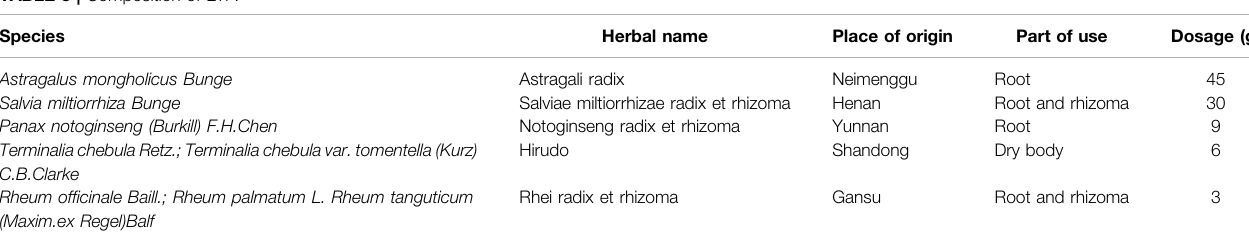
TABLE 3 | Composition of